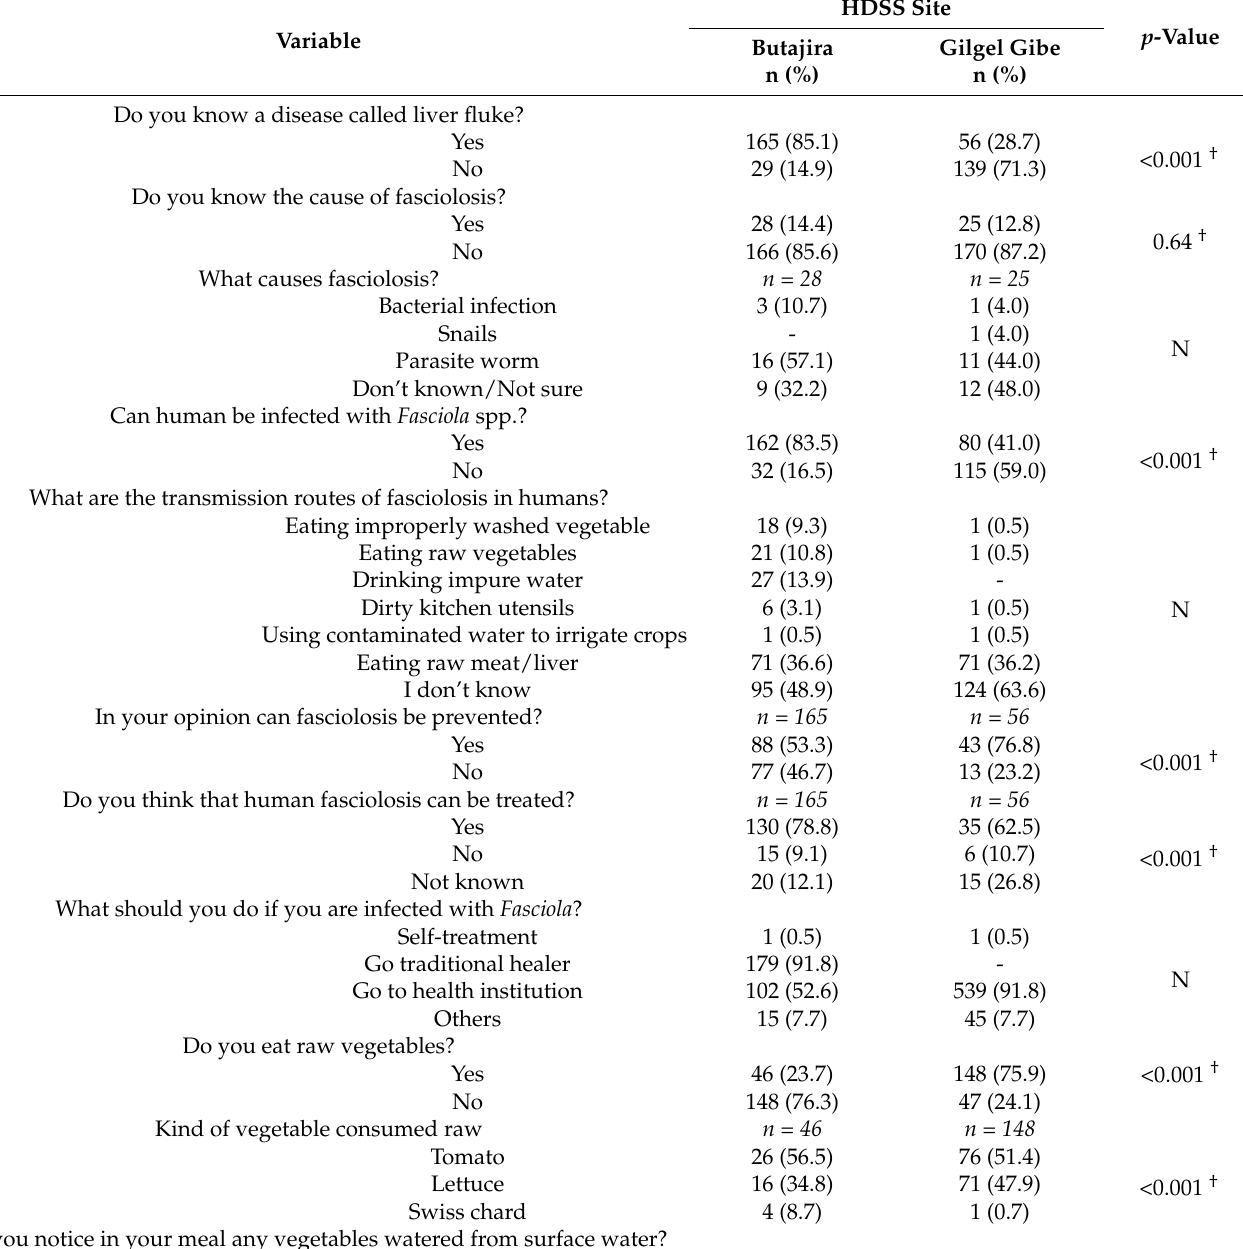
Table 4. Knowledge, attitudes, and practices related to fasciolosis of participants in the Butajira and Gilgel Gibe HDSS sites, Ethiopia. Variable